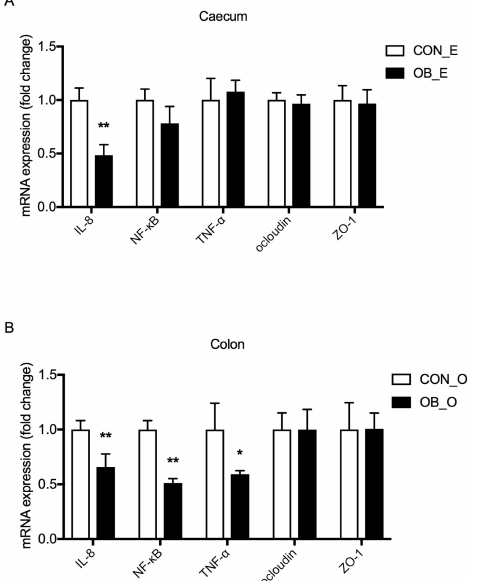
Figure 3. Gene expression in the caecum (E) and colon (O) of growing pigs fed either control (CON) or oat bran diet (OB). ( A ) Intestinal gene expression in the caecum; ( B ) intestinal gene expression in the colon. Values are mean ± SEM, n = 4. Interleukin-8 (IL-8); nuclear factor- κ B (NF- κ B); tumor necrosis factor- α (TNF- α ); zonula occludens-1 (ZO-1). * Compared with the control p < 0.05. ** Compared with the control p <